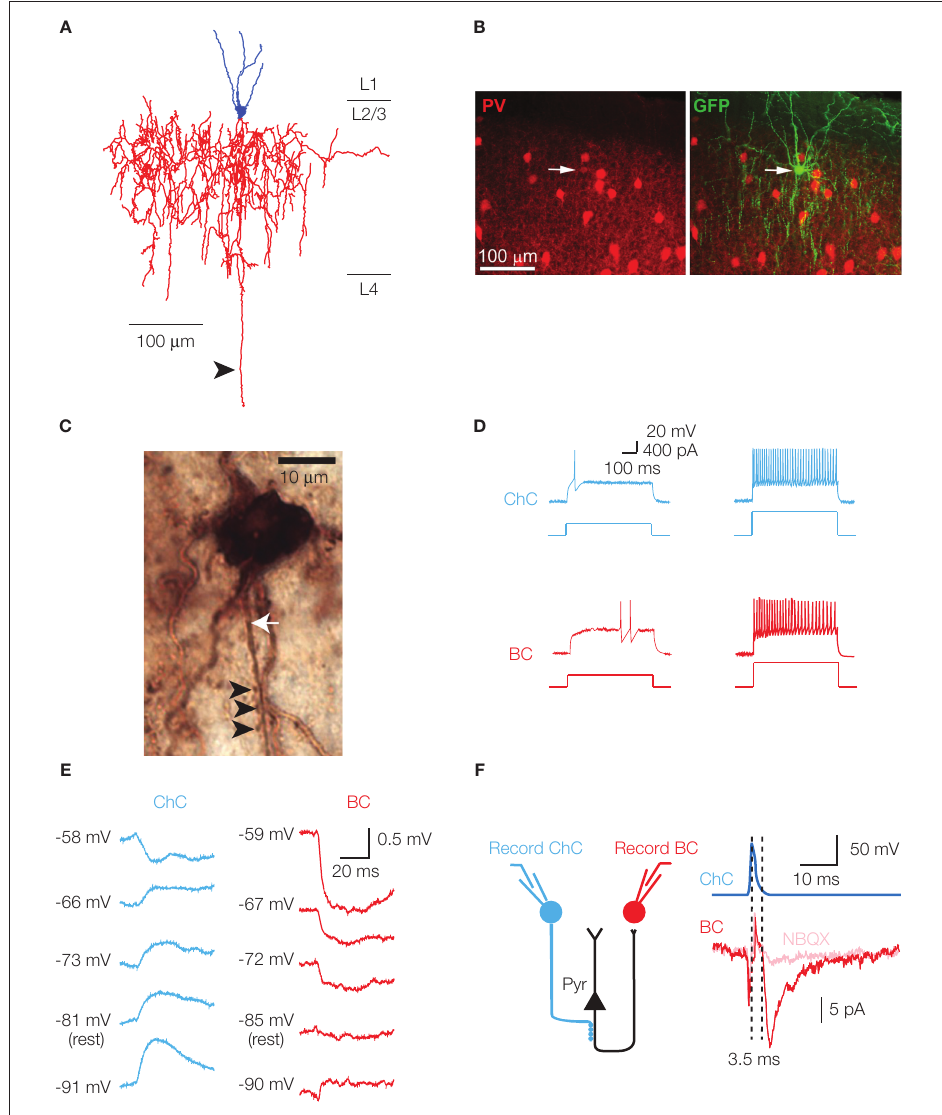
FiGure 1 | Characteristic features of chandelier cells. (A) Neurolucida reconstruction of a layer 2/3 chandelier cell. Cell body and dendrites are in blue, axon in red. Several vertically oriented axonal segments are visible, and are the characteristic morphological feature of ChCs. The long descending axon (arrowhead) reached and arborized in layer 6, but has been digitally truncated. (B) Parvalbumin immunoreactivity of a ChC. A GFP-labeled ChC (right panel, arrow) co-expresses PV (left panel, arrow). (C) Biocytin-filled ChC forms a row of cartridge synapses (arrowheads) on the AIS of a biocytin-filled cortical pyramidal neuron (axon marked by white arrow). (D) Chandelier and basket cells have characteristic responses to threshold current injection. Both cells exhibit the fast-spiking phenotype at higher current intensities (right panel, 2 × threshold illustrated). (e) In cortical layer 2/3 pyramids, E differs at ChC–Pyr and BC–Pyr synapses. (F) ChCs GABA can initiate polysynaptic events. Activation of a GABAergic ChC evokes a response in a simultaneously recorded basket cell. The response (left panel) is sensitive to the AMPA receptor antagonist NBQX, has a disynaptic latency, and is observed in a cell type (BC) that receives no direct synapses from ChCs. Schematic of disynaptic circuit is shown in right panel. (B , D and e) modified, from Woodruff et al.